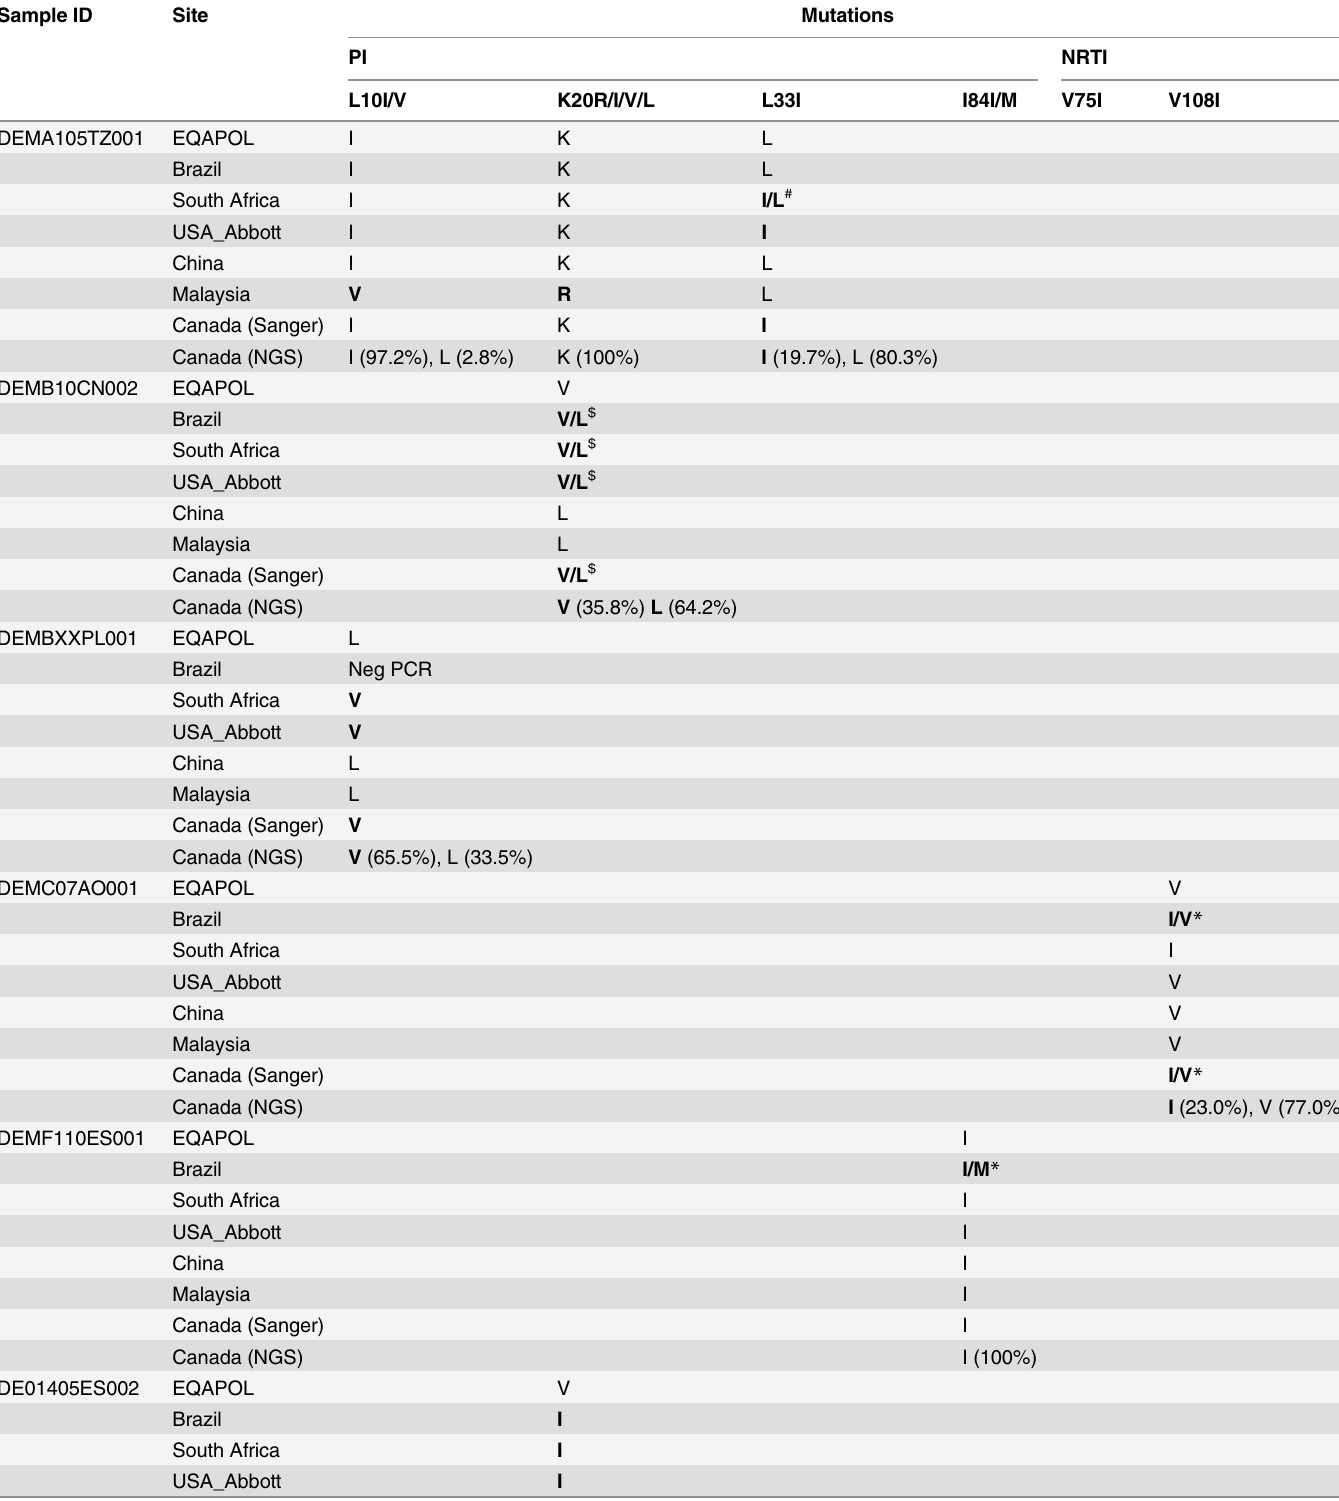
Table 3. Summary of discordant minor DRMs across test sites relative to the EQAPOL